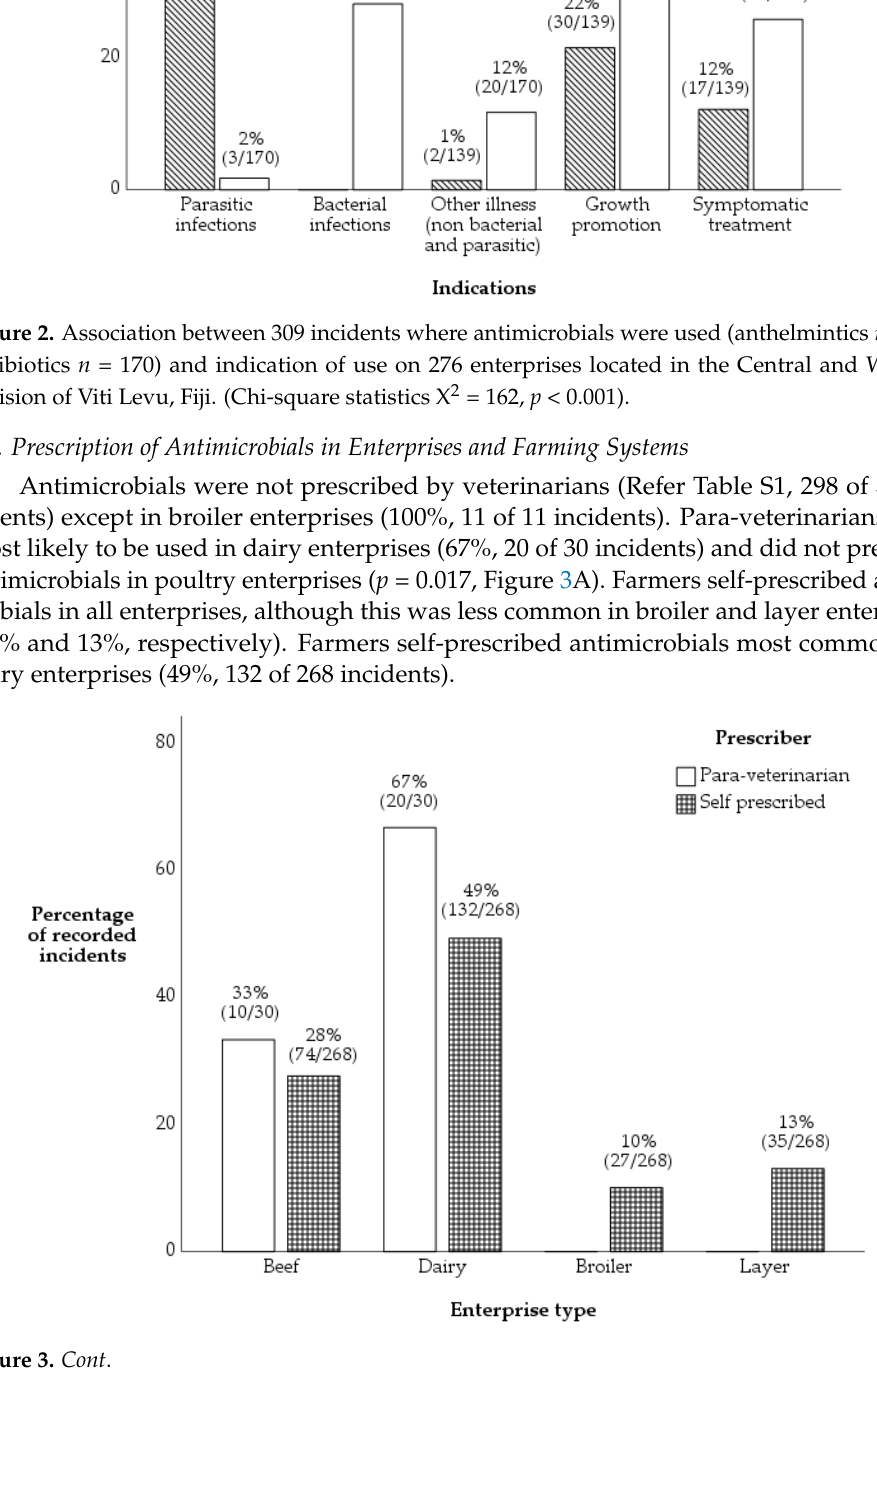
Figure 3. Association between 298 of 309 incidents where antimicrobials were prescribed (para-vet- erinarians n = 30, self-prescribed n = 268) and A. different enterprises (Fisherman’s exact test, p = 0.017) and B. different farming systems (Fisherman’s exact test, p = 0.111) located in the Central and Western divisions of Viti Levu, Fiji. Veterinarians only prescribed in commercial broiler enterprises ( n = 11 incidents) and were excluded from the analysis. 2.5. Associations and Logistic Regression Modelling of Farming System and Enterprise Type with AMU Practice Amongst the different farming systems, antibiotics were used imprudently in more incidents in the semi-commercial farming system (98%). The situation was only margin- ally better in the backyard (92%) and commercial (76%) farming systems. There was an